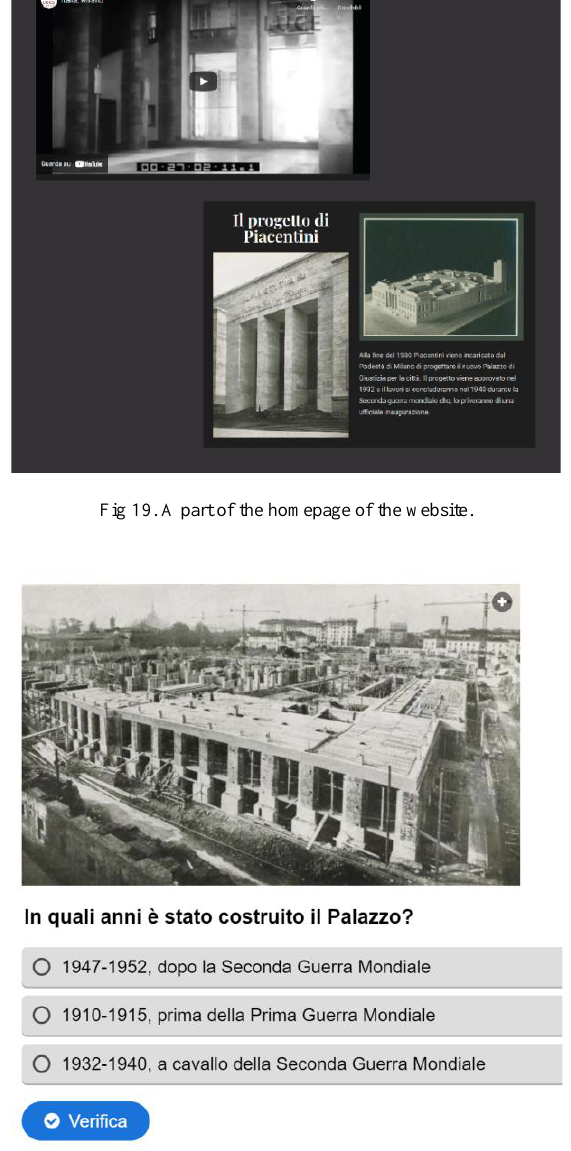
Fig. 20. Questionnaire about the